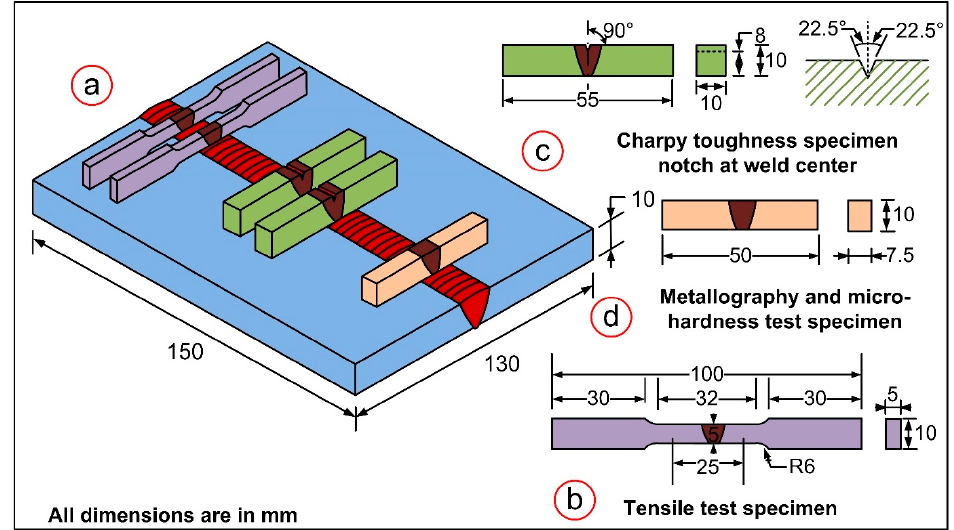
Figure 2. Schematic showing the ( a ) welded plate with specimen positions, ( b ) standard tensile specimen, ( c ) impact toughness specimen, ( d ) specimen machined for metallography and hardness testing.